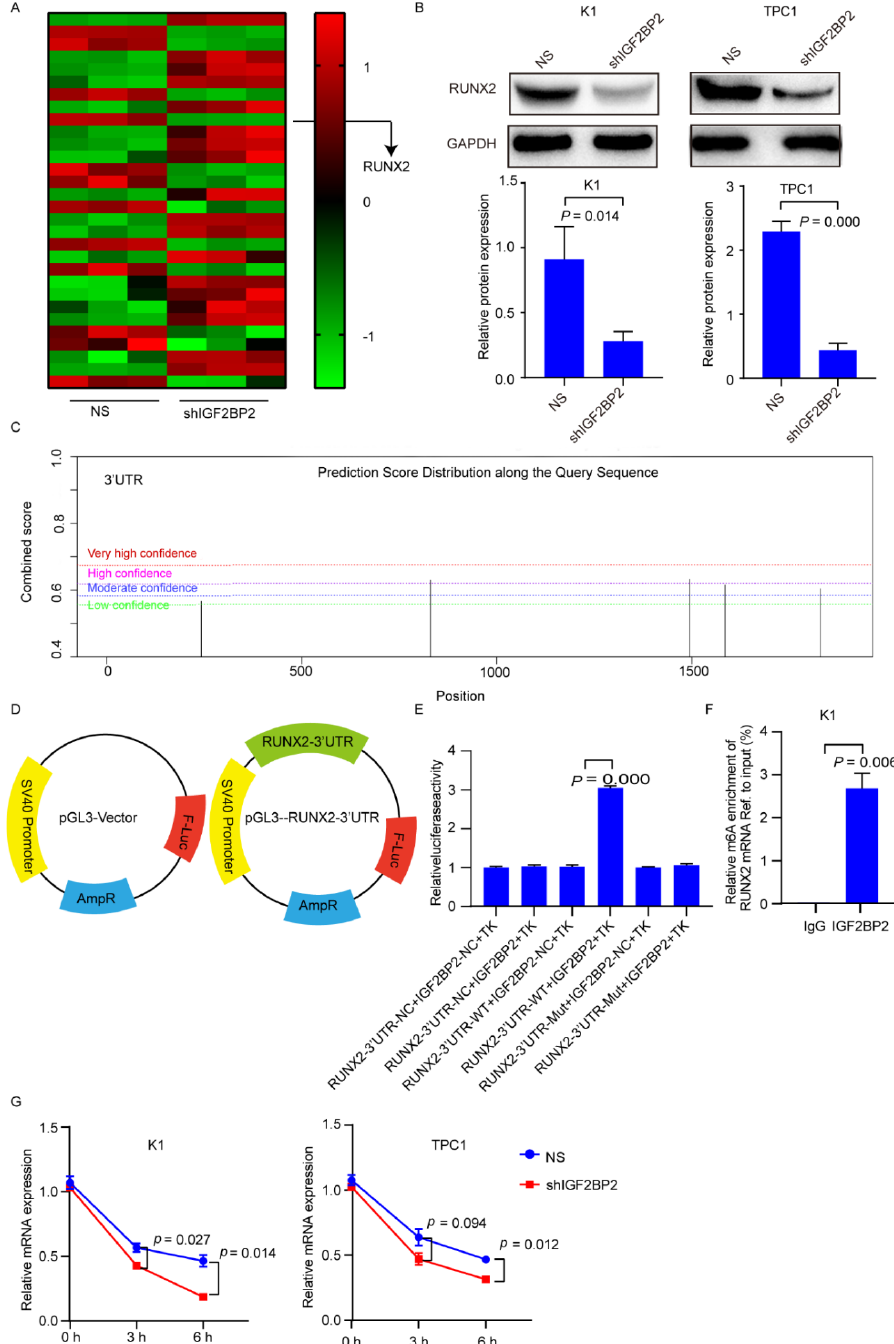
Figure 4. RUNX2 is a potential target of IGF2BP2. ( A ) Heatmap of differentially expressed genes, of which RUNX2 is associated with cell differentiation in K1 cells via knockdown of IGF2BP2. ( B ) RUNX2 protein expression in K1 and TPC1 cells with or without knockdown of IGF2BP2. ( C ) Prediction of potential m6A binding sites in 3 (cid:48) -UTR of RUNX2 mRNA. ( D ) Graphical explanation for construction of luciferase reporters with wild-type or mutant (m6A motif mutated) sequence of RUNX2-3 (cid:48) -UTR inserting into a pGL3 vector. ( E ) Relative luciferase activities in TPC1 cells with stably expressing IGF2BP2 or vector co-transfected with RUNX2-3 (cid:48) -UTR wild-type or mutant luciferase reporters. ( F ) Relative enrichment of RUNX2 mRNA associated with IGF2BP2 protein using anti-IgG and anti-IGF2BP2 antibodies. ( G ) mRNA stability of RUNX2 in K1 and TPC1 cells with or without knockdown of